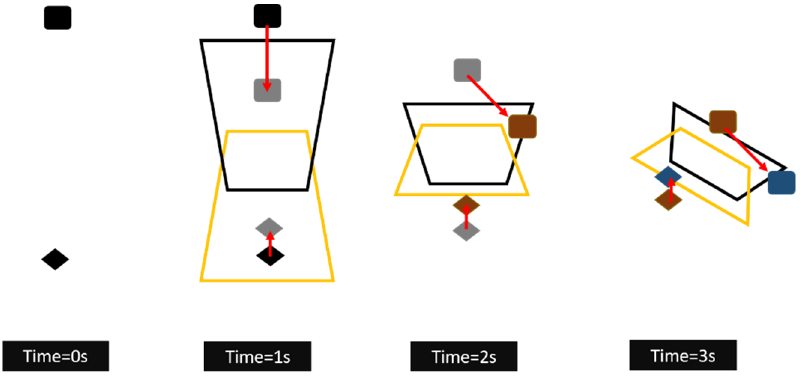
Figure 10. The sequence of robots avoiding obstacles interactively.